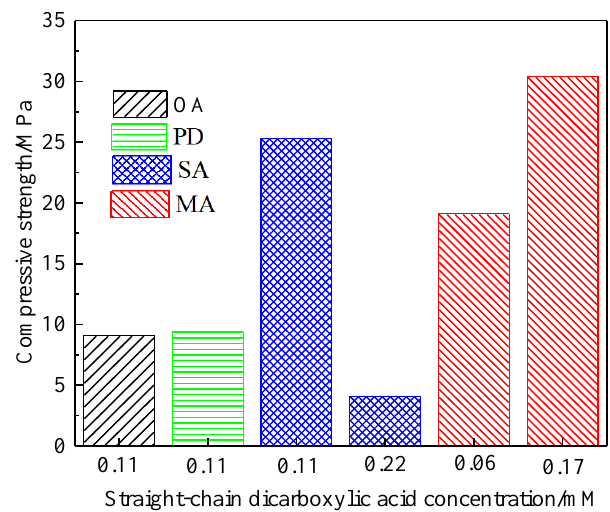
Figure 11. Effect of straight-chain dicarboxylic acid concentration on the compressive strength of α-CaSO 4 ·0.5H 2 O.